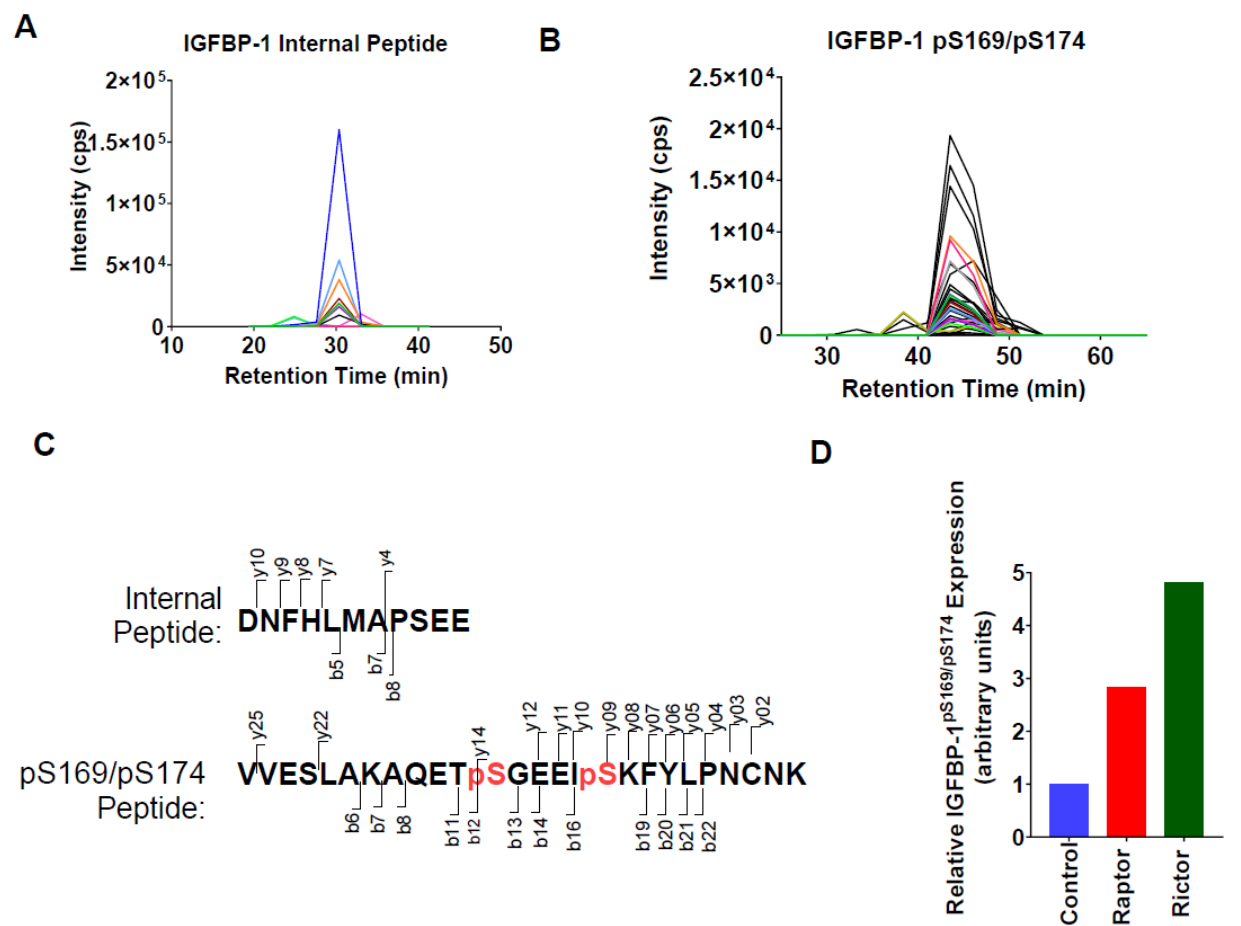
Figure 4. Parallel Reaction Monitoring Mass Spectrometry (PRM-MS) analysis identified increased IGFBP-1 phosphorylation at pSer169/pSer174 following incubation in CM from PHT cells with mTOR inhibition. To determine relative levels of dual IGFBP-1 phosphorylation at pSer169 and pSer174, PRM-MS was performed, as no antibodies were available to assess this modification. De- tection of IGFBP-1 ( A ) internal ( m / z = 645.2770, z = +2) and ( B ) pS169/pS174 ( m / z = 1015.4623, z = +3) peptides by PRM-MS. Displaying chromatograms of individual fragment ions. ( C ) The red font in- dicates the peptide sequences and fragmentation patterns corresponding to panels A and B. Serine phosphorylation sites. ( D ) The peak area of pS169/pS174 peptides normalized to the peak area of the internal peptide control, shown as relative to the control (non-coding) siRNA.